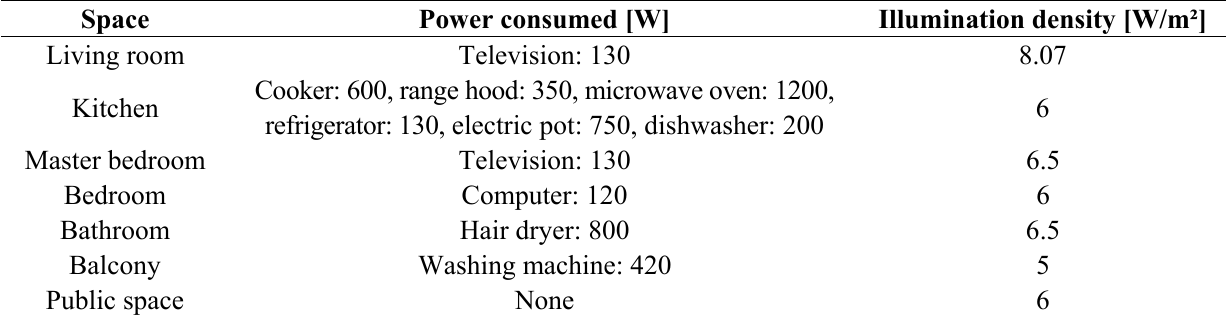
Table 3. Electricity consumption of household